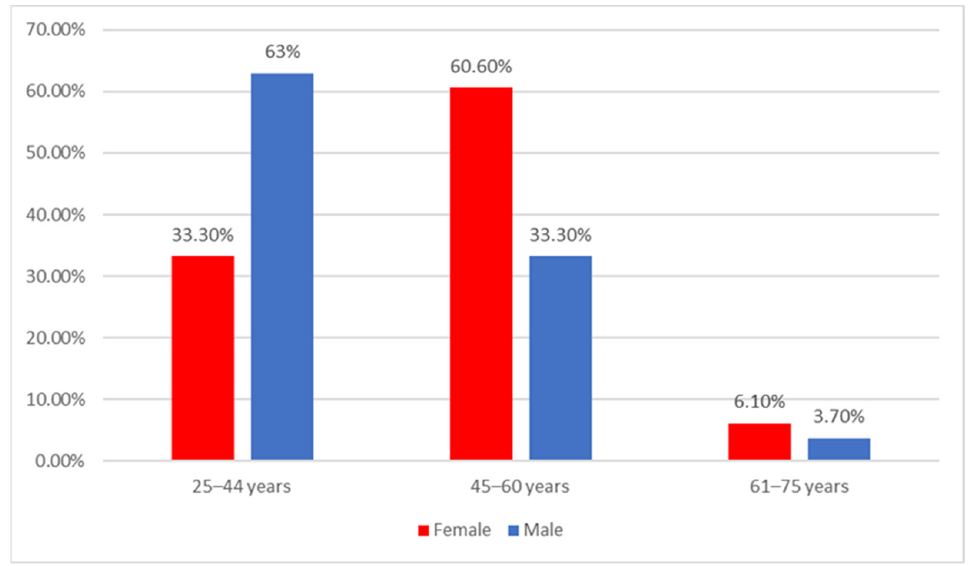
Figure 1. Distribution of the university teachers according to age and gender.